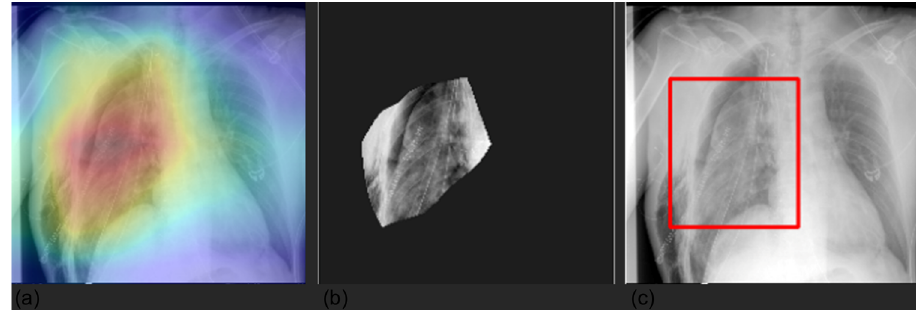
Figure 6. Visualization of pneumothorax prediction maps for a selected CXR. The panels represent the saliency mask obtained with Grad-CAM (panel a ), the relevant area (mask values higher than the 0.8 quantile) (panel b ), and the respective bounding box (panel c ). The saliency mask, as emphasized by the heat map (panel a ), focuses on the right lung field, which shows the pneumothorax.